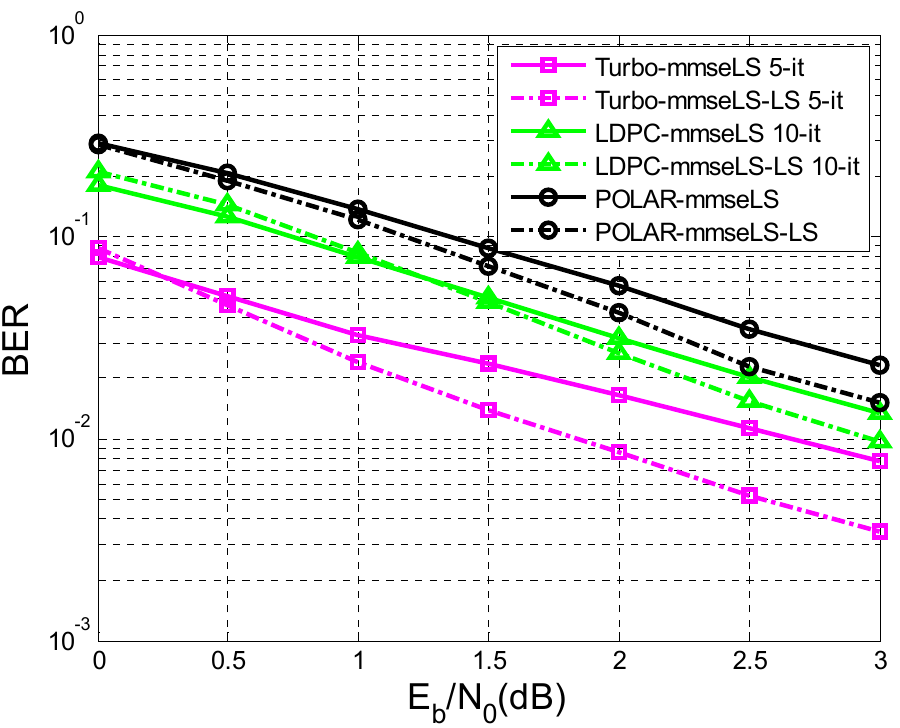
Figure 15. BER vs. SNR for different codes in the case of MMSE equalization applying iterative LS estimation (K = 342 bits h = (0.18 0.85 0.32), N = 16).